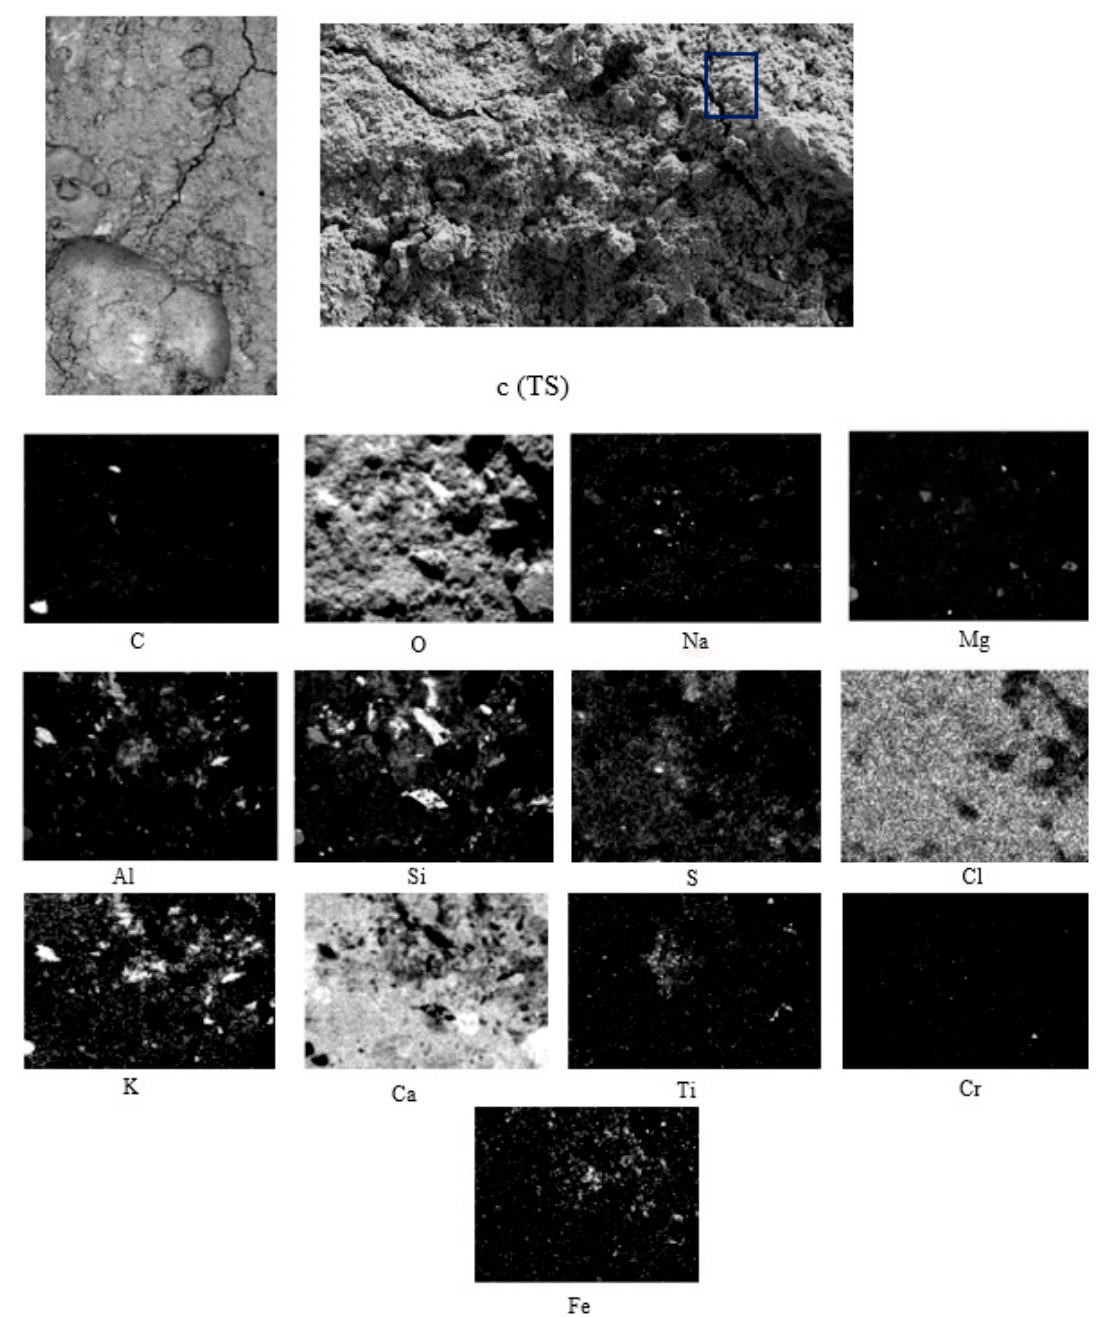
Figure 11. SEM-BSE of TS and EDS map of element distribution in TRAD mortar sample. (c) Sam- pling.